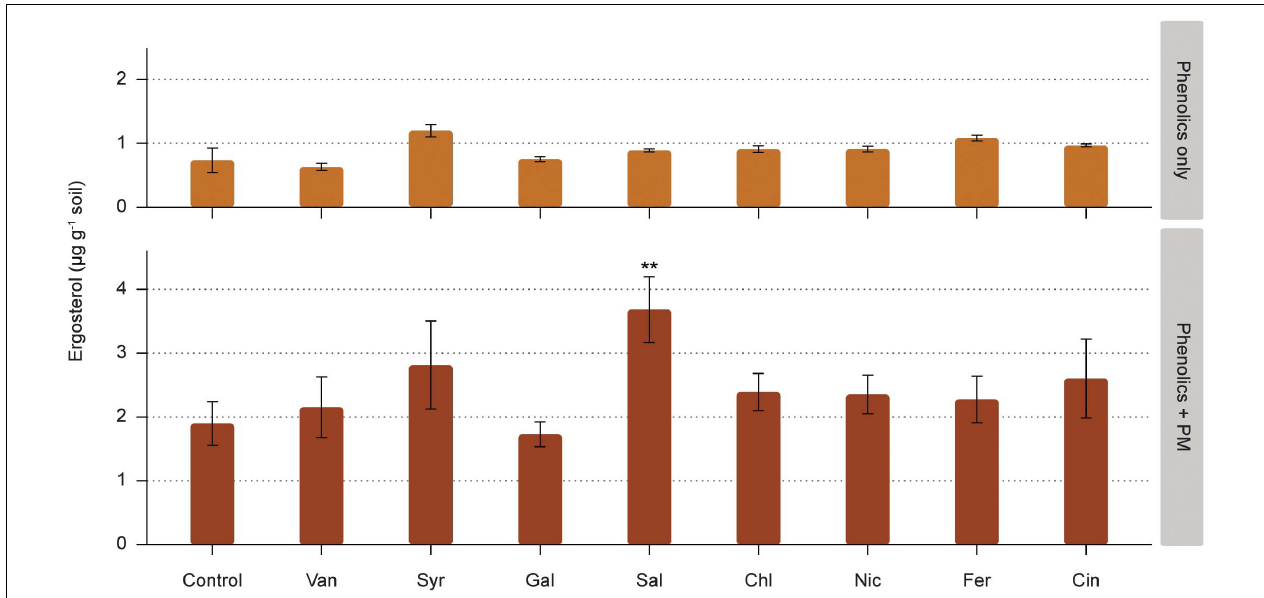
FIGURE 2 | Effect of phenolic acids on fungal biomass, as measured in the soil compartment of rhizosphere simulation microcosms. Phenolic acids were vanillic acid (Van), syringic acid (Syr), gallic acid (Gal), salicylic acid (Sal), chlorogenic acid (Chl), nicotinic acid (Nic), ferulic acid (Fer), and cinnamic acid (Cin). Phenolic acids were added alone or with a background of soluble primary metabolites (PM). Significant differences to the control (water and PM only, respectively) are shown for phenolic acids without and with PM (** 0.01 > p > 0.001).